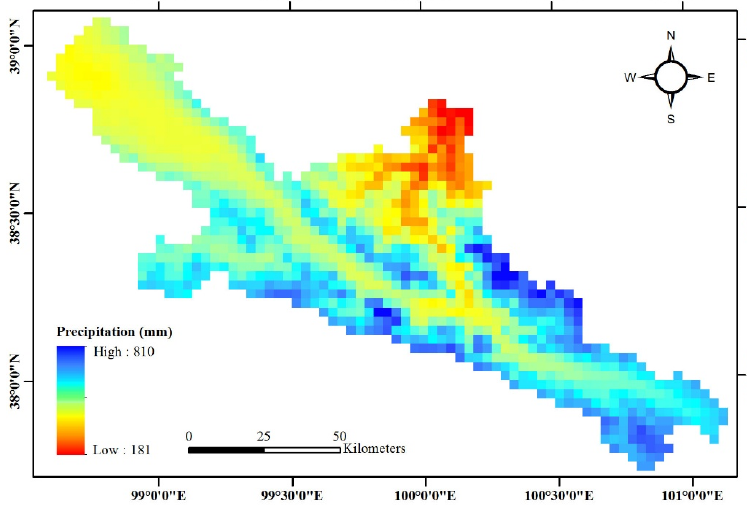
Figure 5. Distribution of the average annual gridded precipitation.